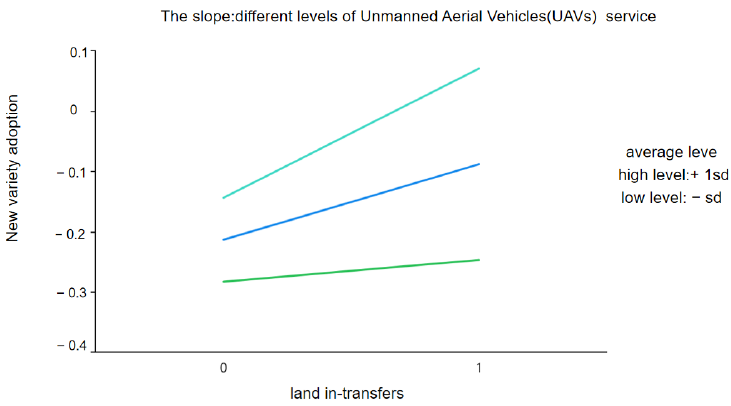
Figure 7. The relationship between land in-transfers and the adoption of new varieties.